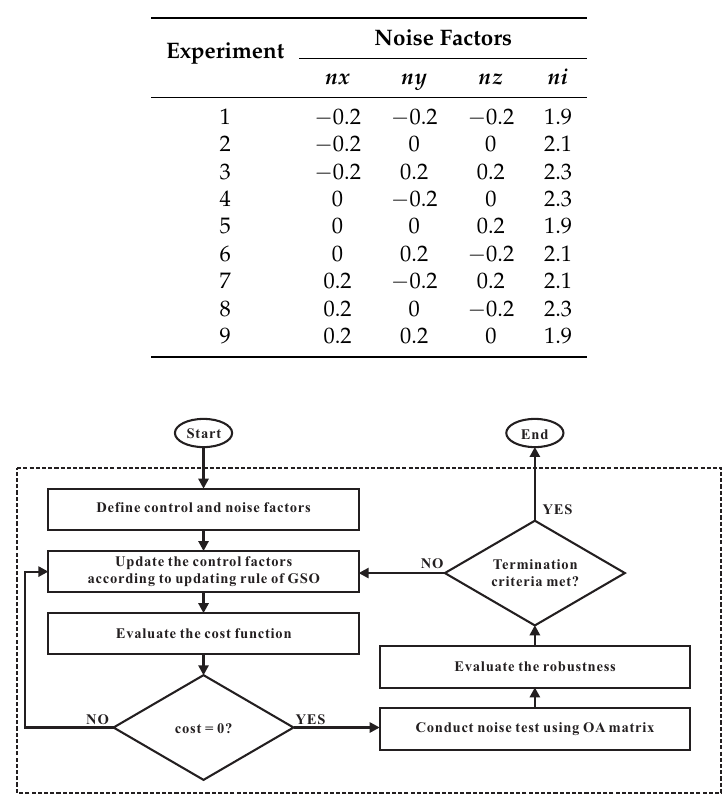
Figure 8. Flowchart of the robust design